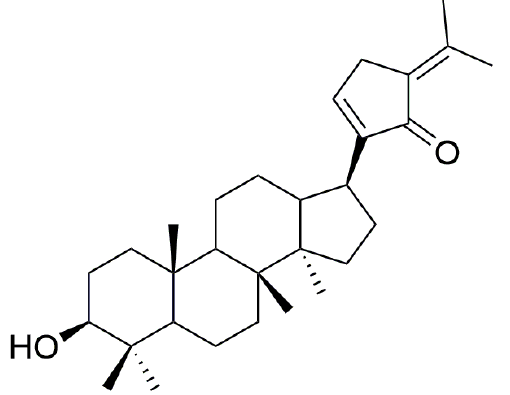
Figure 1. Chemical structure of GPC.